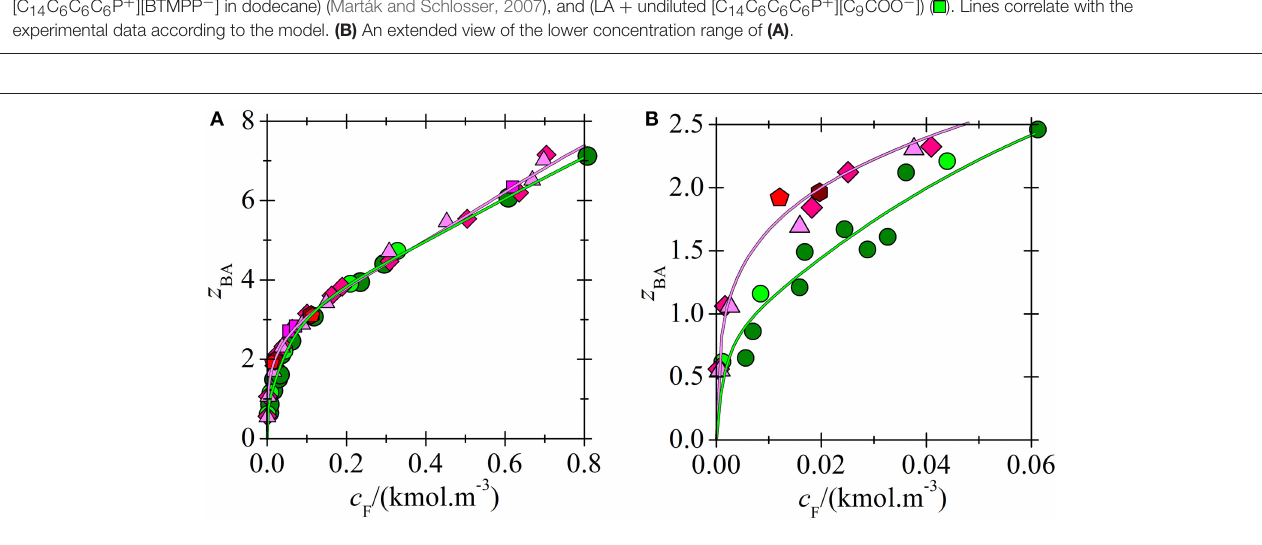
FIGURE 6 | Loading of phosphonium ILs by acids vs. aqueous equilibrium concentration of acid in systems (BA + undiluted [C 14 C 6 C 6 C 6 P + ][BTMPP − ]) ( ) (Marták and Schlosser, 2016), (BA + undiluted [C 14 C 6 C 6 C 6 P + ][C 9 COO − ]) ( ) (Marták and Schlosser, unpublished manuscript), (LA + undiluted ( ) or 70 wt. % ( )